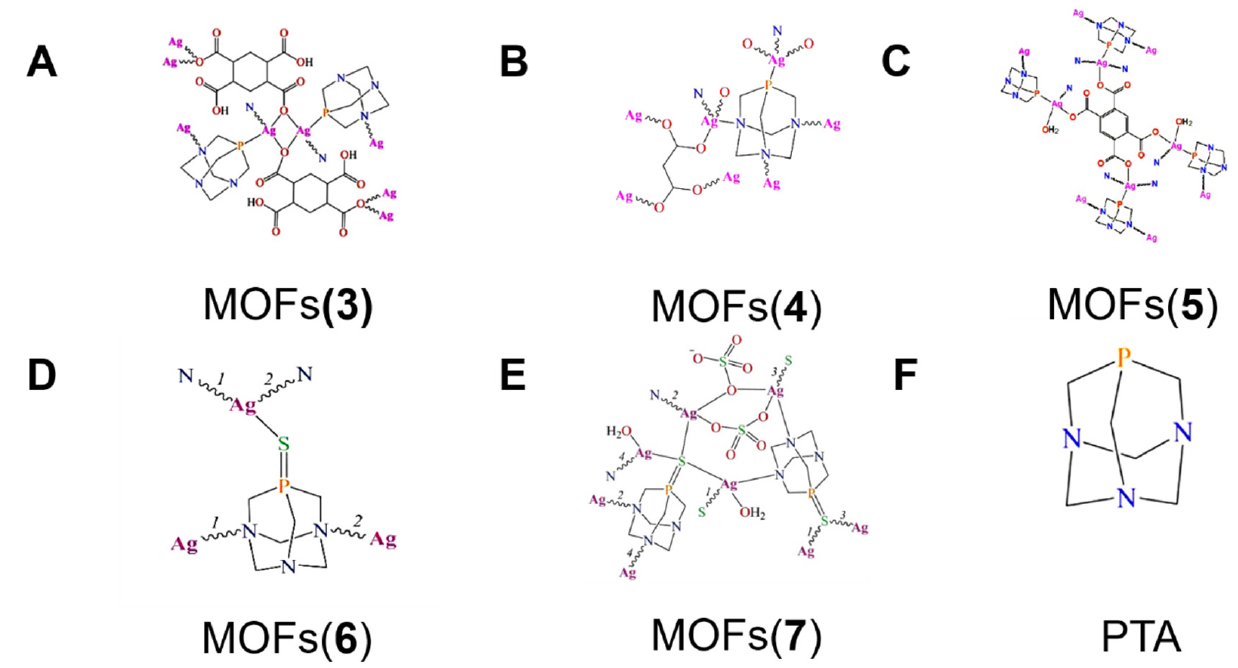
Figure 2. The structural formulas of MOF ( 3 ) ( 4 ) ( 5 ) ( 6 ) ( 7 ) and the PTA. Reproduced with permission from [100–103].